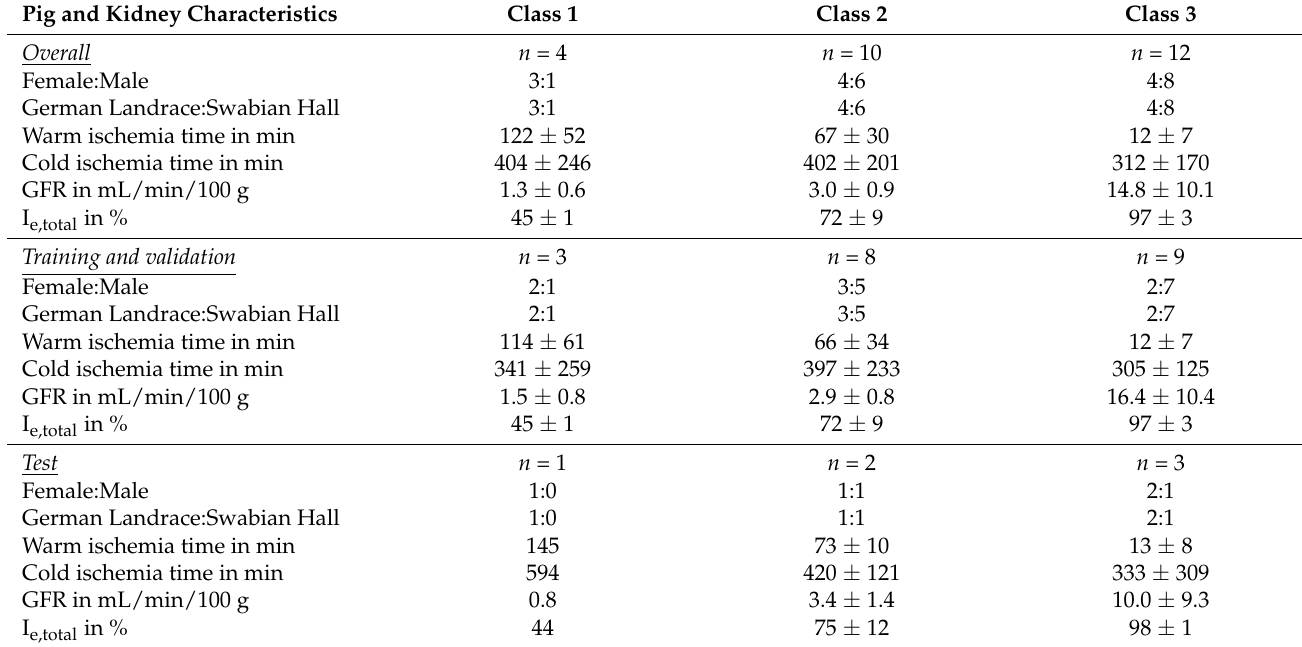
Table 1. Overview of kidneys preserved ex vivo with normothermic machine perfusion (NMP). Listed are the sex, race, warm ischemia time, cold ischemia time, glomerular filtration rate (GFR) and inulin eliminated from the blood during NMP (I e,total ) for all kidneys of a class, kidneys in the training and validation data set, and kidneys in the test data set. Data are presented as mean ± standard